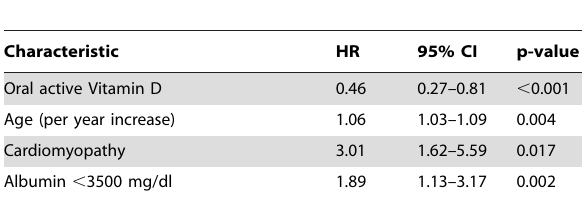
Table 4. Multivariate analysis of risk factors for all-cause